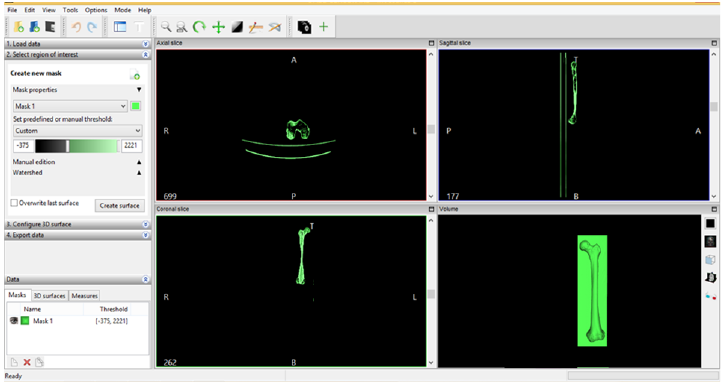
Figure 27. InVesalius interface for the second set of CT scans.